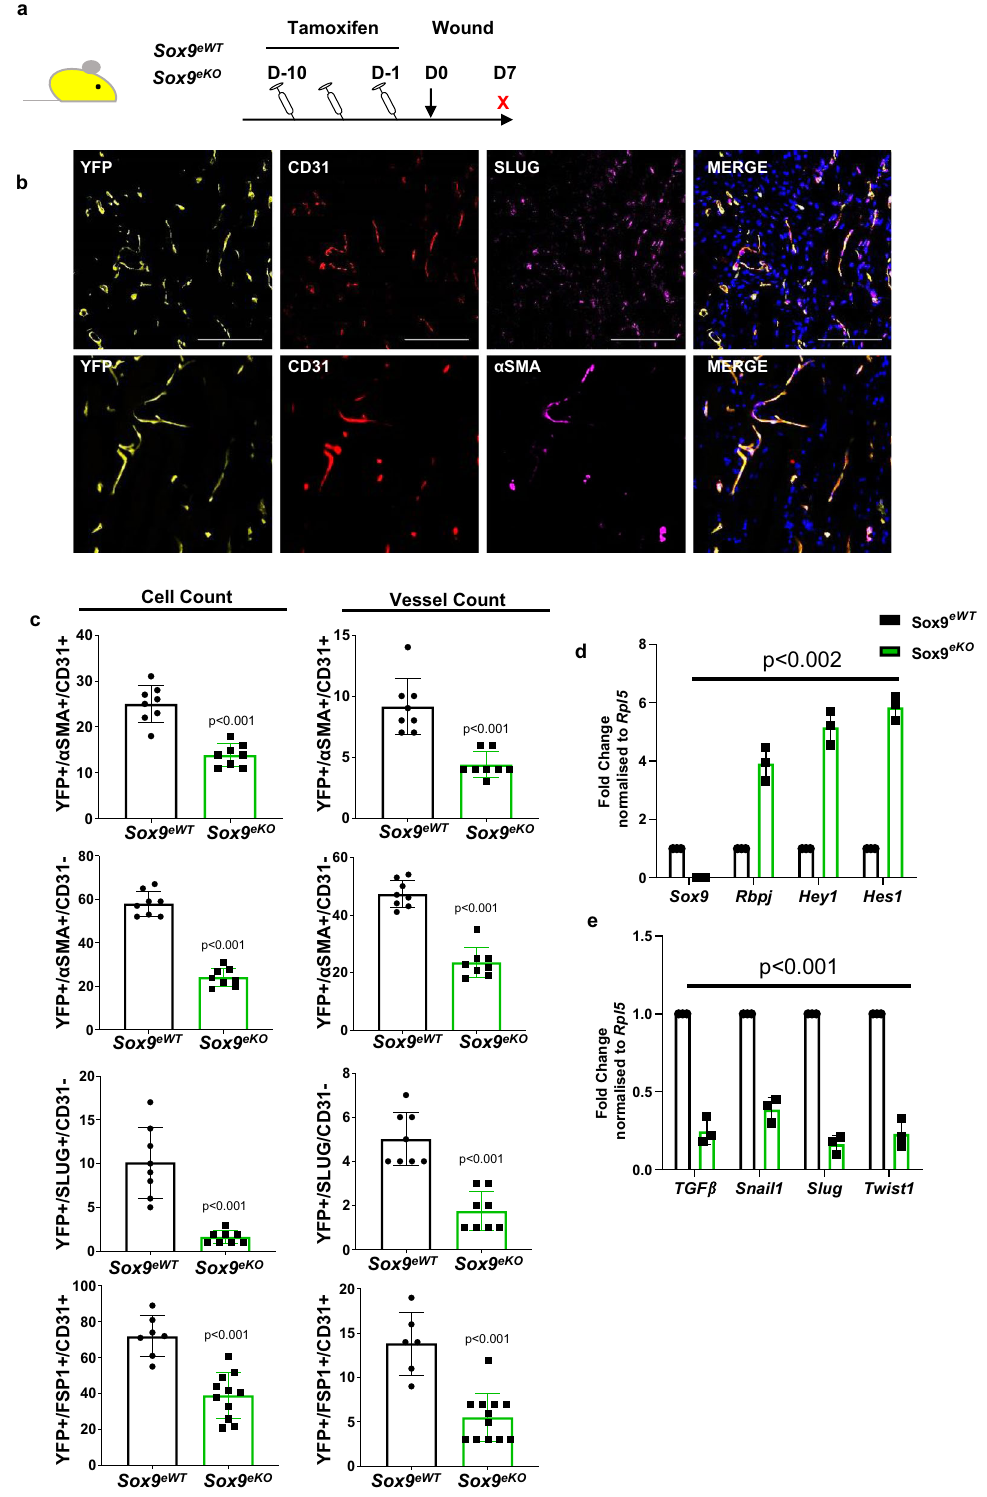
Fig. 4 Quanti fi cation of endothelial to mesenchymal transition (EndMT) upon loss of SOX9. a Schematic diagram demonstrating experimental set up using conditional vascular speci fi c Sox9 knockout mice ( Sox9 fl / fl /Cdh5-Cre ER RosaYFP – Sox9 eKO ). b Examples of immuno fl uorescence staining of skin wound sections at day 7 (D7) with endothelial markers CD31, lineage marker YFP and EndMT markers SLUG or α SMA. Scale bar = 50 µ m. c Quanti fi cation of EndMT showing overlap of YFP + cells with either endothelial and mesenchymal markers such as SLUG, α SMA and FSP1 (** p < 0.01 vs Sox9 eWT ; n = 5 biologically independent animals; mean ± SD; p value was calculated by two-tailed unpaired t test). d , e qPCR analysis of key endothelial and EndMT genes in EVP from Sox9 eKO compared to Sox9 eWT (** p < 0.01; *** p < 0.001 vs Sox9 eWT ; n = 3; cells were sorted from three groups of fi ve biologically independent animals; mean ± SD; p value was calculated by two-way ANOVA with multiple comparison of row